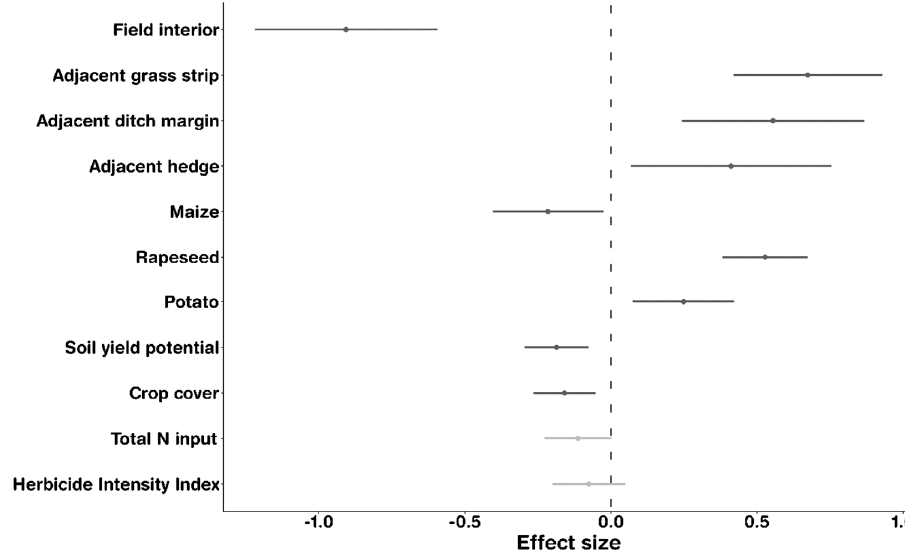
Figure 3. Effect sizes (mean estimate of the coefficients and 95% confidence intervals) of the influence of adjacent habitat type (field edge plots adjacent to grass strips, ditch margins and hedges or field interior plots, i.e., no adjacent habitat), crop type (maize, potato, rapeseed), management ‐ related factors (Herbicide Intensity Index, crop cover, total nitrogen input) and edaphic properties (soil yield potential) on total herbaceous plant species richness of the surveyed arable fields according to the generalized mixed effects model (n = 255 plots on 14 farms, 15 of 270 plots were excluded due to missing values of management data). The effects of the categorical variables were calculated relative to species richness of the respective reference levels (adjacent habitat type: field edge plots bordering another field; crop type: winter cereal fields (wheat, barley, rye and triticale pooled)). The coefficients for numeric predictors were rescaled by twice of the standard deviation for reasons of comparability [45]. Non ‐ significant effects are highlighted in light grey. See Table S3 for details about the statistical analyses, including original values of all coefficients. Note that the significant effects of maize, potato and adjacent hedge compared to the respective reference level (all cereals pooled or adjacent arable field) were not consistently supported by all statistical analyses (Figures 2 and 4).